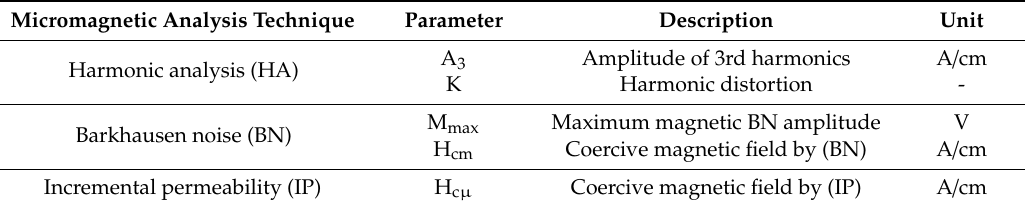
Table 2. Parameters measured in micromagnetic analysis.